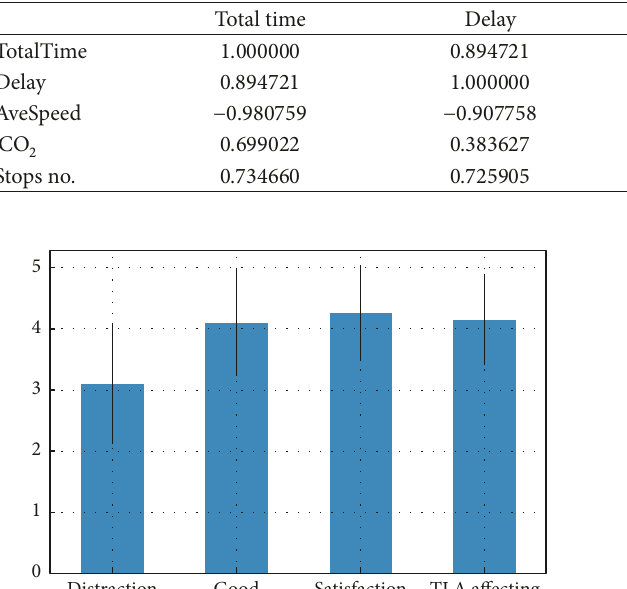
Figure 8: Graphical representation of the correlations depicted in Tables 2 (Scenario 1) and 3 (Scenario 2). Table 3: Correlation matrix between the monitored indicators in Scenario 2.